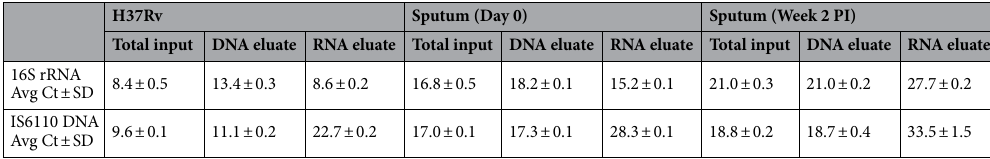
Table 1. Passing Mtb lysates through a DNA column prior to RNA purification captures a substantial portion of the Mtb DNA. Total input represents the nucleic acids recovered from the RNA column when the Mtb lysate was not first passed through a DNA column to remove DNA; DNA eluate represents nucleic acids recovered from the DNA column after the Mtb lysate was passed through it; and RNA eluate represents nucleic acids recovered from the RNA column when the Mtb lysate was first passed through the DNA column to remove DNA. Samples were not DNase treated; Average cycle threshold values from three replicates for each condition are presented, PI post-initiation of therapy with first-line drugs, Avg average, SD standard deviation.